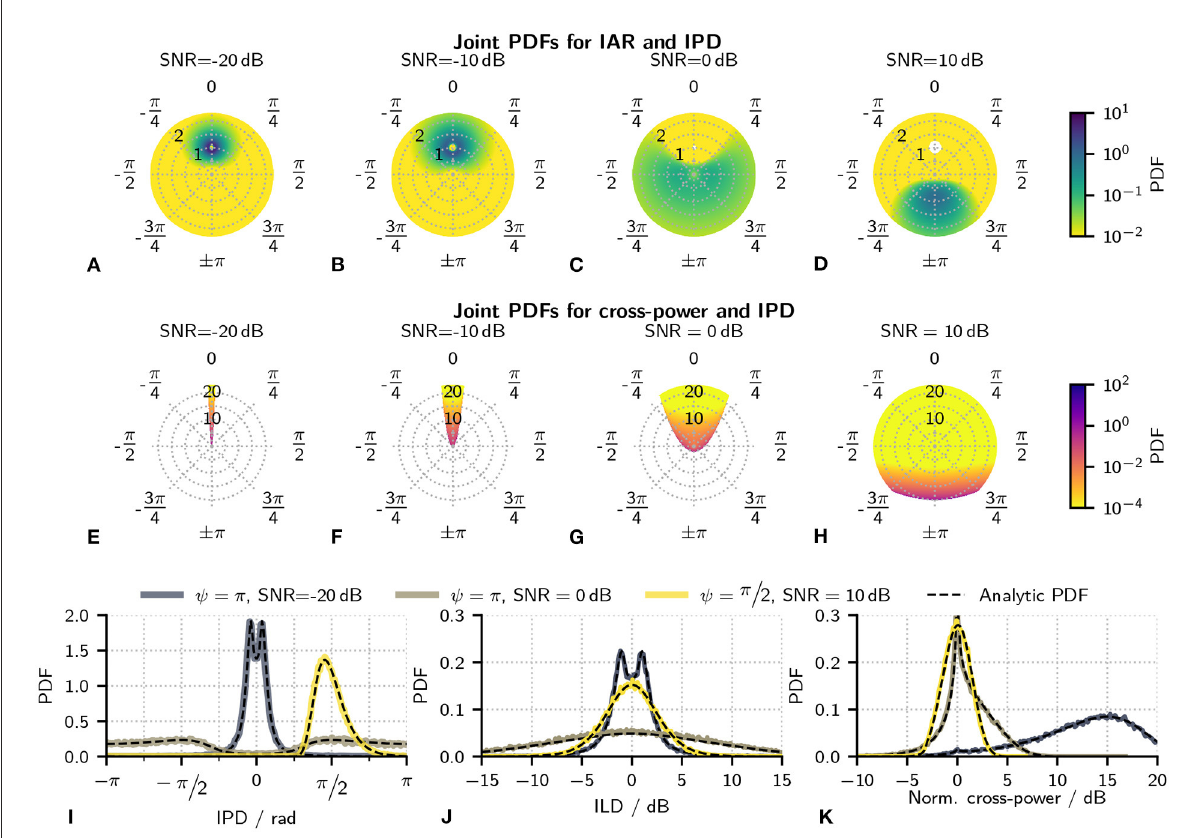
FIGURE2 (A–D) Some examples of the joint PDF of IAR and IPD given in Equation (18). All plots show results for a tone-IPD of π with the SNR increasing from left to right. Angles in the polar plot are the IPDs, while the radial variable is the IAR. Colors indicate the probability density. A logarithmically-scaled colormap was used due to the large dynamic range of the PDF. White areas located at an IAR = 1 and IPD = 0 for 0 and 10dB indicate a probability density of 0. (E–H) Joint PDF for cross-power and IPDs given in Equations (20). Results are shown for the same parameters as in (A–D) . As in the first row of plots, angles indicate the IPD and color the probability density. The radial variable, however, is the cross-power. These PDFs were calculated for a noise variance of σ 2 1. A logarithmically-scaled colormap was used due to the large dynamic = range of the PDF. White areas indicate undefined combinations of cross-power and IPD as defined by Equation(23). (I–K) Evaluation of the analytical results by comparing the derived marginal PDFs with numerically estimated PDFs. In all cases, black, dashed lines indicate analytical results gained from Equations (24)–(27). Colored lines indicate results that were instead numerically estimated from waveforms. Panel (I) shows marginal PDFS for IPDs 18 , (J) for ILDs 1 L and k) for the cross-power P ′